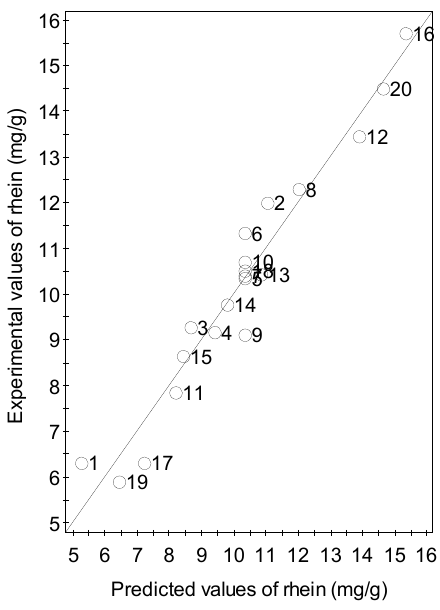
Figure 4. Experimental versus predicted values of rhein amount.